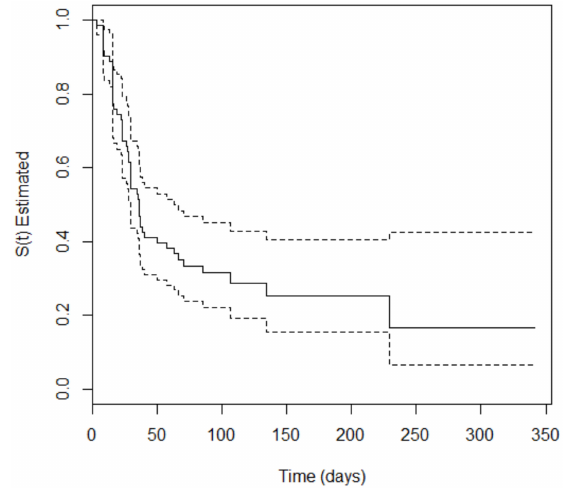
Figure 1. Kaplan–Meier curve (solid line) with 95% confidence interval (dotted line) corresponding to patients with hematologic malignancies.